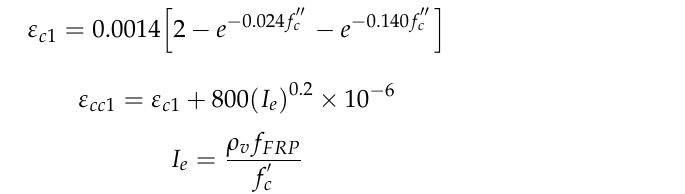
where I e is the effective confinement index (non-dimensionless parameter); ρ v is the volu-